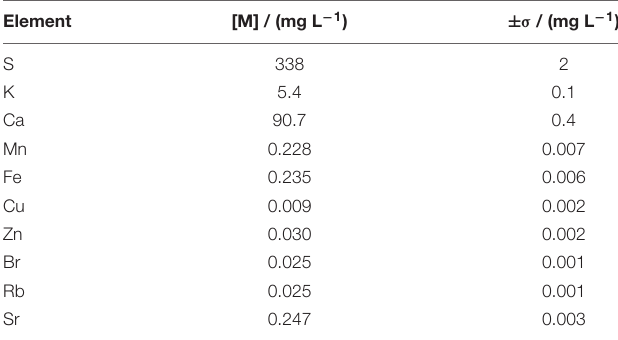
TABLE 1 | Elements identified in the Mars regolith extract by total X-ray fluorescence